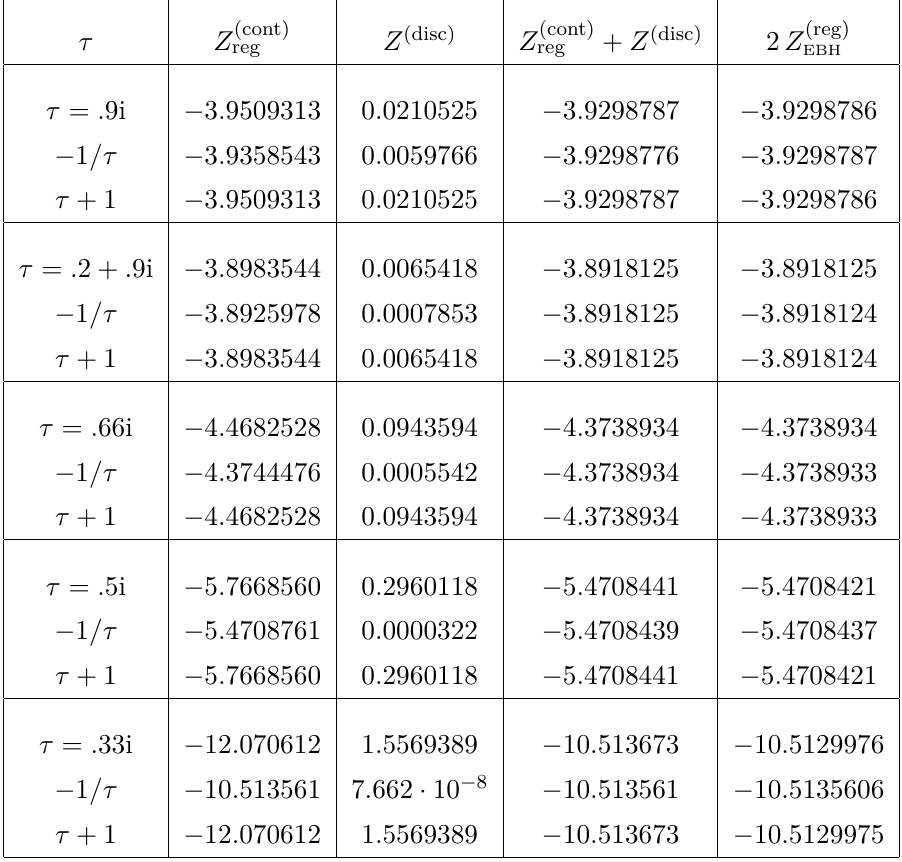
Table 1 . A comparison of the numerical data for twice the regularized partition function of the Euclidean black hole NLSM (8.14) with Z (cont) reg + Z (disc) for the case k = 0 and n = 3 . Here Z (disc) is given by eqs. (7.17) and (7.18), while Z (cont) reg is defined by (8.16). The table also